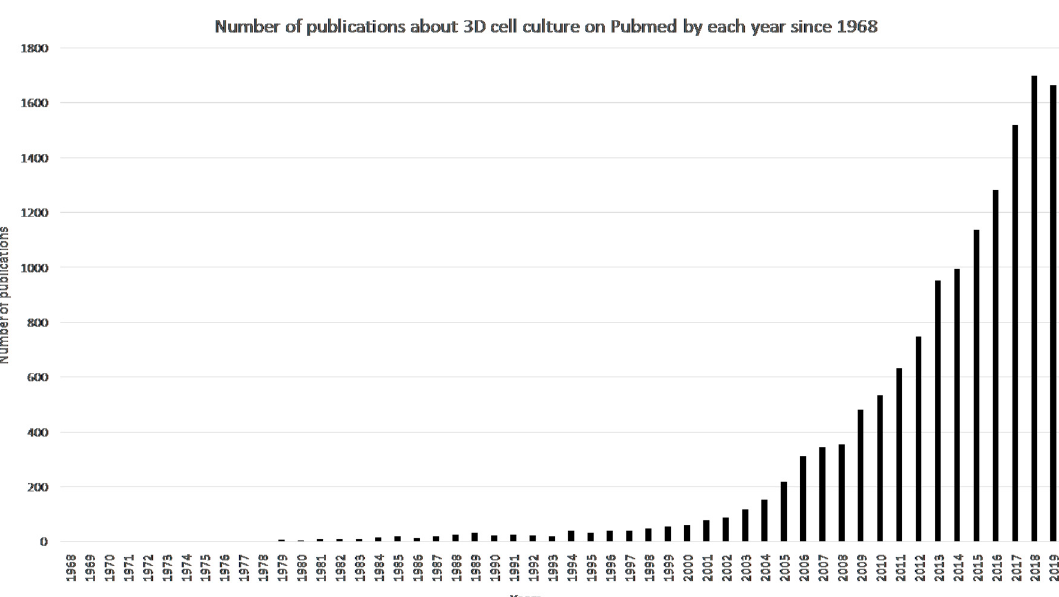
Figure 3. Number of publications per year about 3D cell culture on Pubmed since 1968. The number of publications is the number obtained when entering the keyword “3D cell cultures” in the search bar and applying the filter of results by year on Pubmed website.